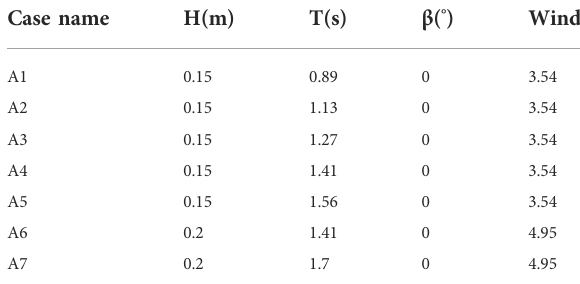
TABLE 5 Experimental